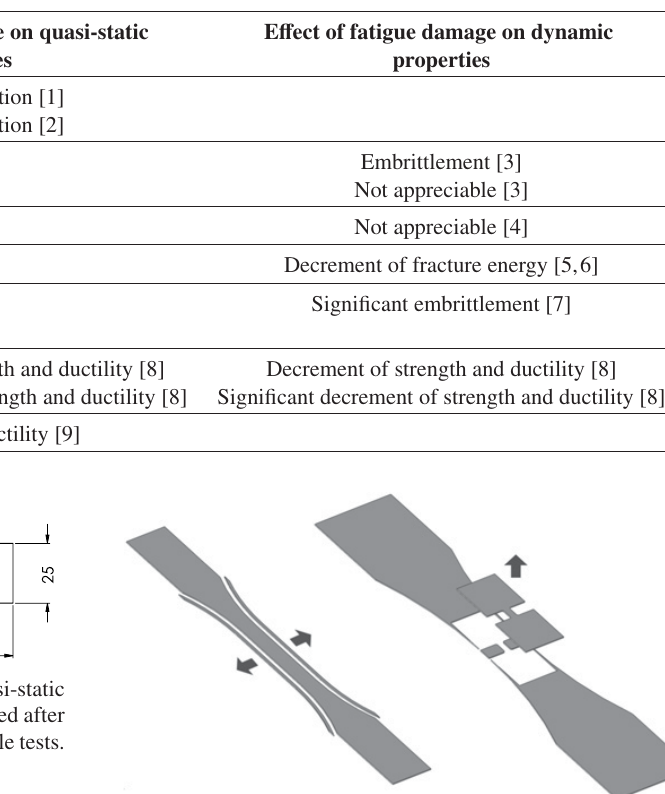
Table 1. E ff ect of previous fatigue damage on the quasi-static and / or dynamic tensile properties of engineering materials. Horizontal lines separate the results of di ff erent research groups.